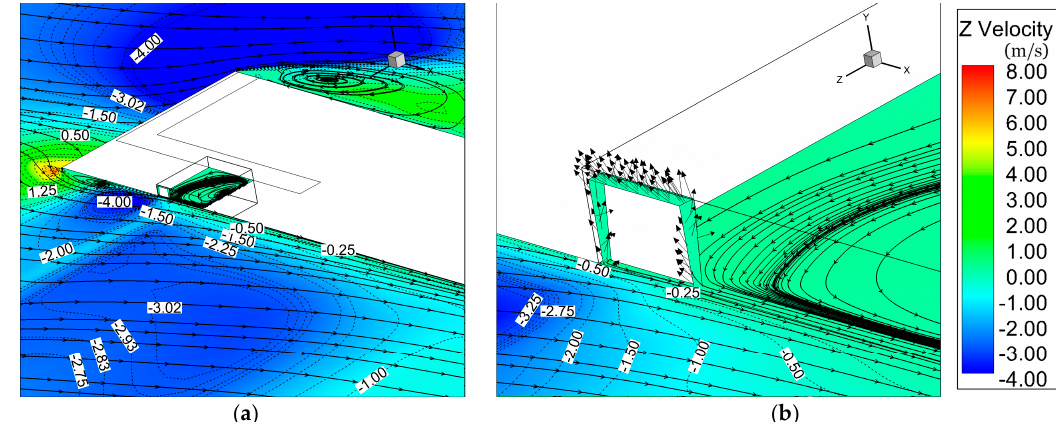
Figure 14. Flow patterns and contour of velocity (z-component) for 10 m / s wind speed and wind direction of 215 ◦ , ( a ) around the building, ( b ) in front of the tilted window.